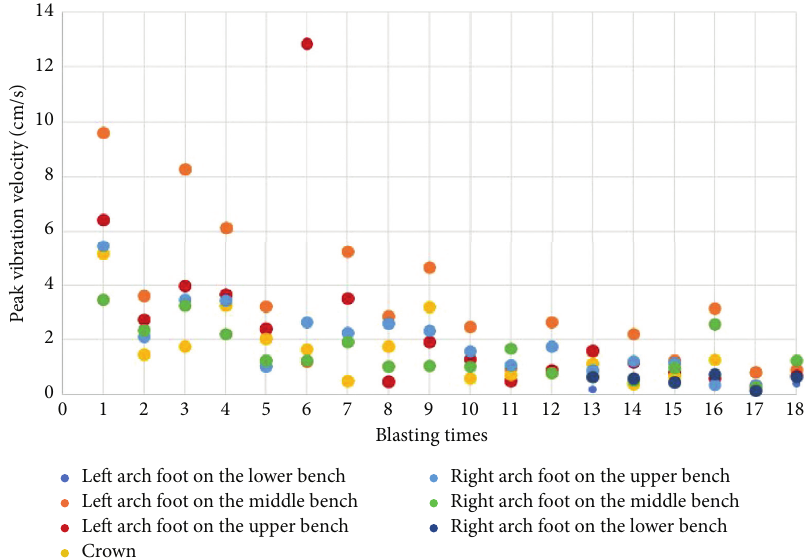
Figure 13: Contrast diagram of tangential vibration velocity at different positions of the tunnel.